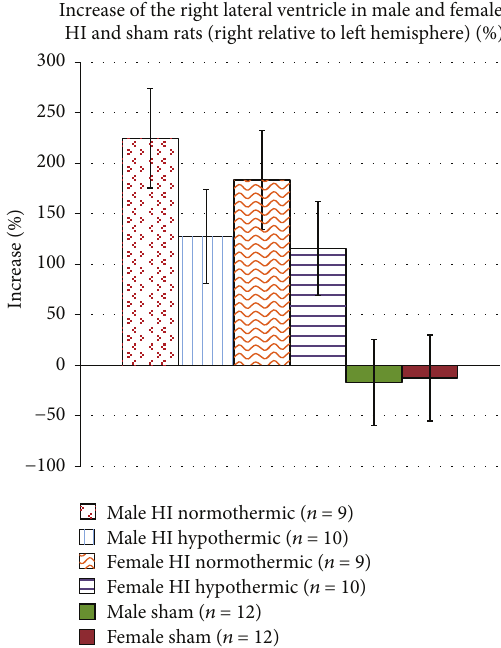
Figure 2: A 2 (Sex) × 2 (Injury) × 2 (Temperature) ANOVA revealed a significant Injury effect ( 𝑝 < 0.05 ). Independent samples 𝑡 -tests did not yield significant effects.